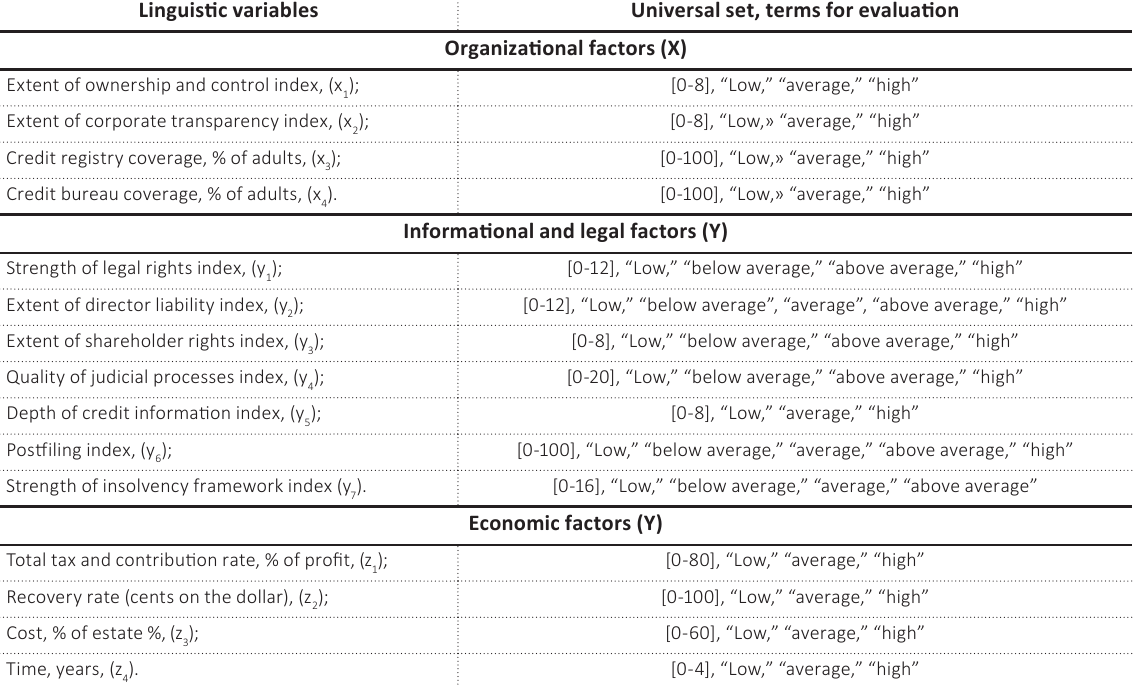
Table 2. Systematization of factors for the proposed model (D) Linguistic variables